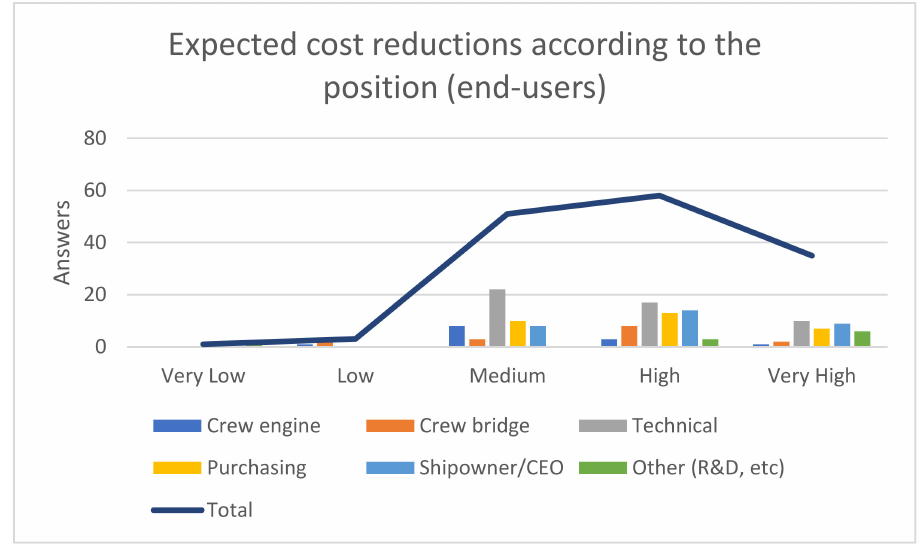
Figure 2. Expected cost reductions according to the position in the